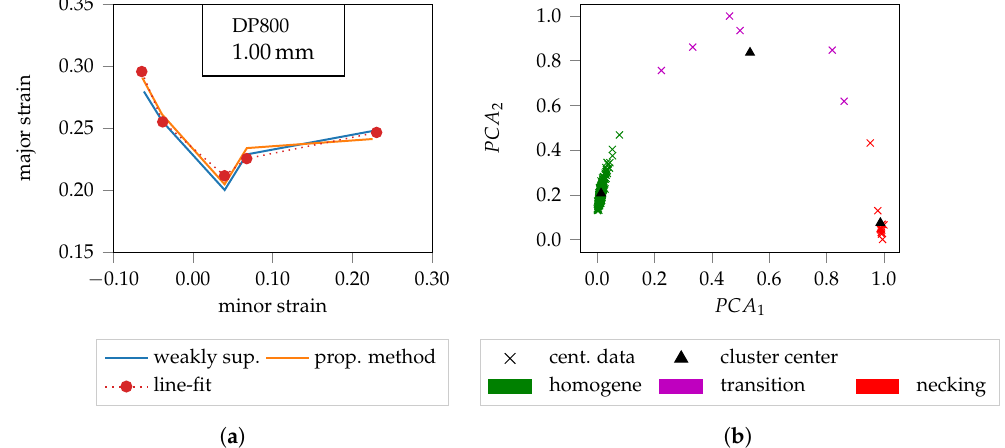
Figure 7. Comparison of the weakly supervised approach and the proposed method together with the impact of outliers: ( a ) DP800 FLC candidates. ( b ) Especially the transition region contains outliers that affect the cluster position.